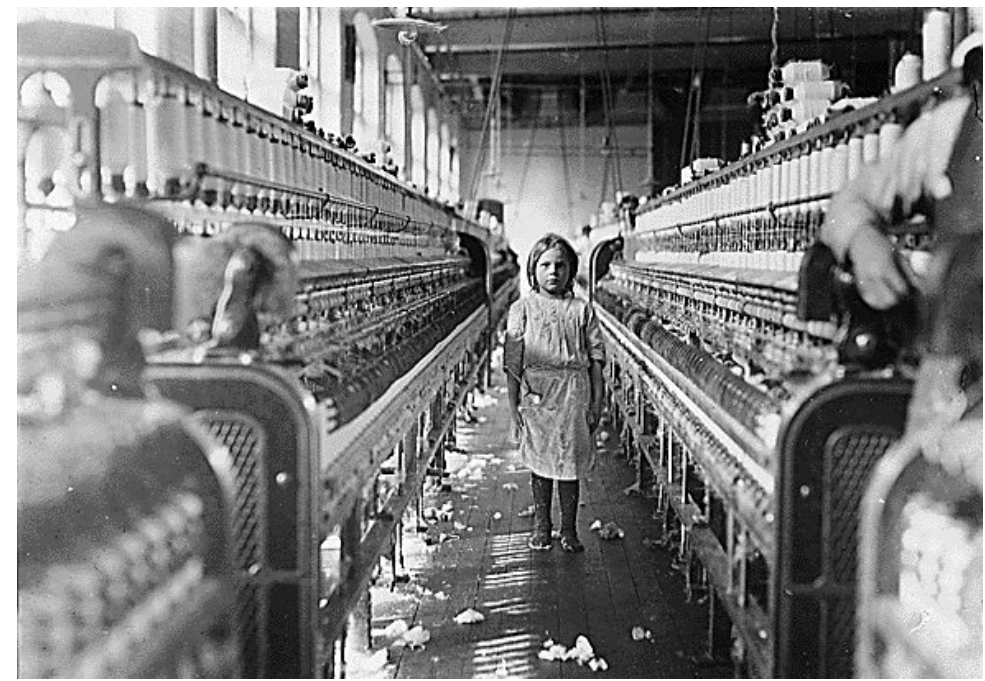
Figure 18. Lewis Hine, 1908, New England Mill. Library of Congress.